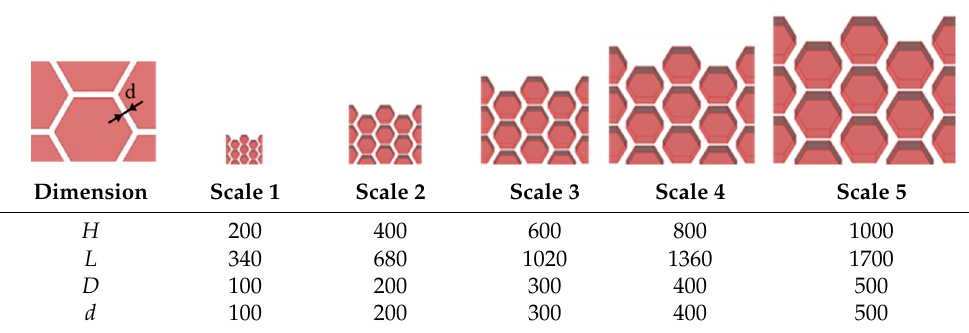
Table 4. Experimental conditions employed in the ball-on-disk tribological